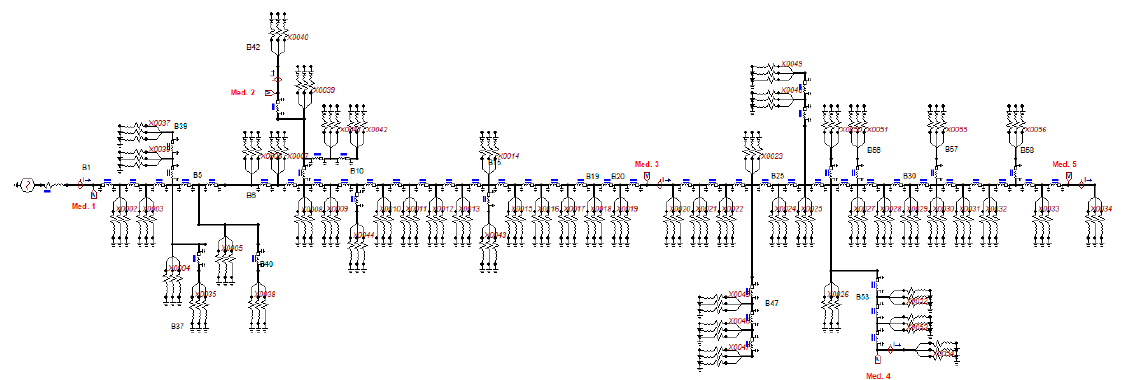
Figure 6. Real urban distribution system (58 nodes) modeled in the alternative transient program (ATP) software.